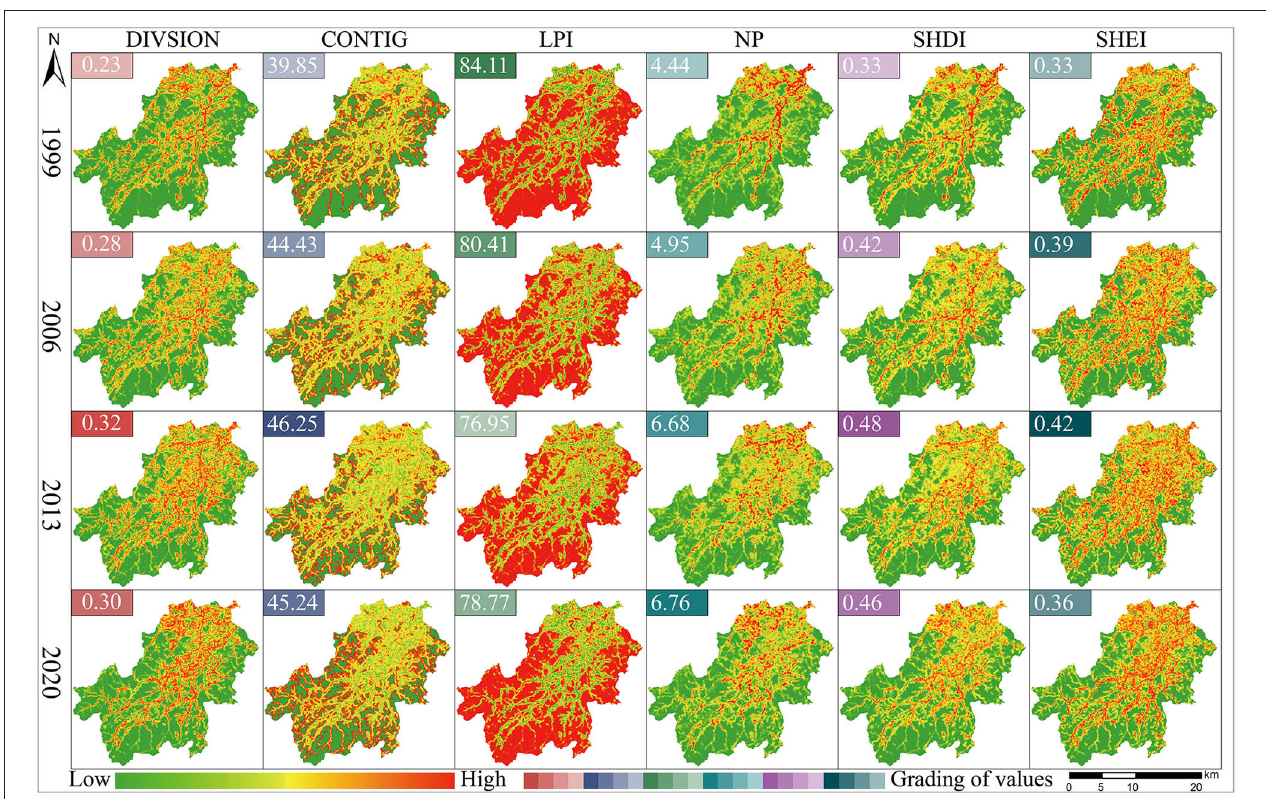
FIGURE 5 | Spatial distributions of landscape metrics for the periods 1999–2020. The value in the figure is the average value of each landscape metric.